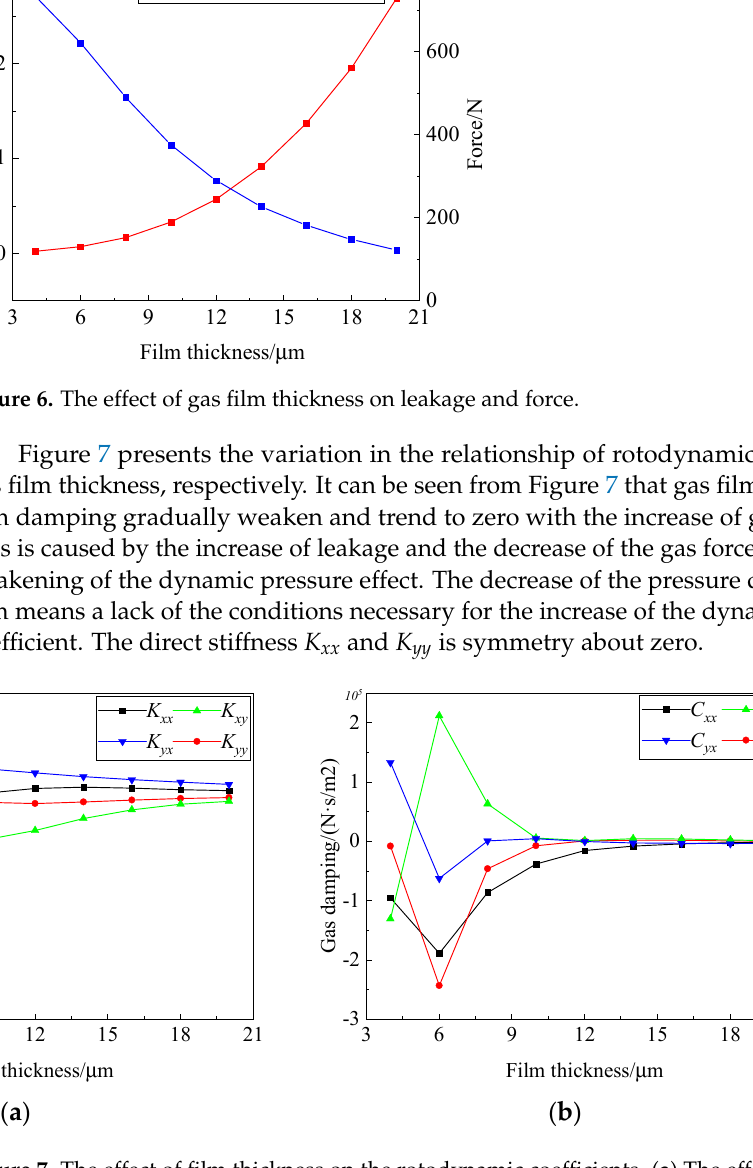
Figure 7. The effect of film thickness on the rotodynamic coefficients. ( a ) The effect of film thickness on gas stiffness; ( b ) The effect of film thickness on gas